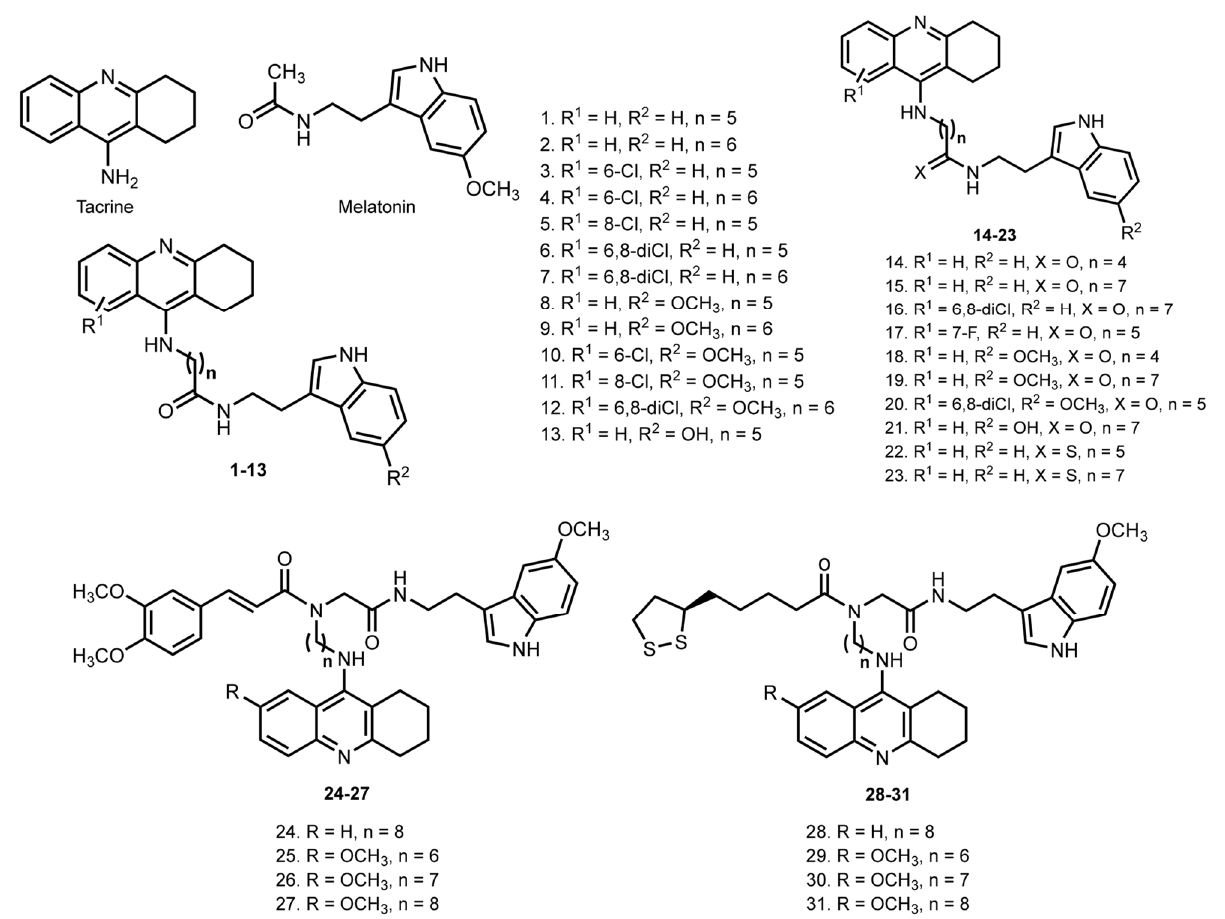
Figure 4. THA–melatonin hybrids 1 – 13 [39], an extended series of THA (6 ‐ Cl ‐ THA)–melatonin hy ‐ brids 14 – 23 [40], and THA–melatonin hybrids with ferulic acid or lipoic acid 24 – 31